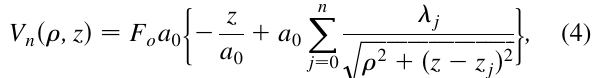
FIG. 7. (Color) The function P r .